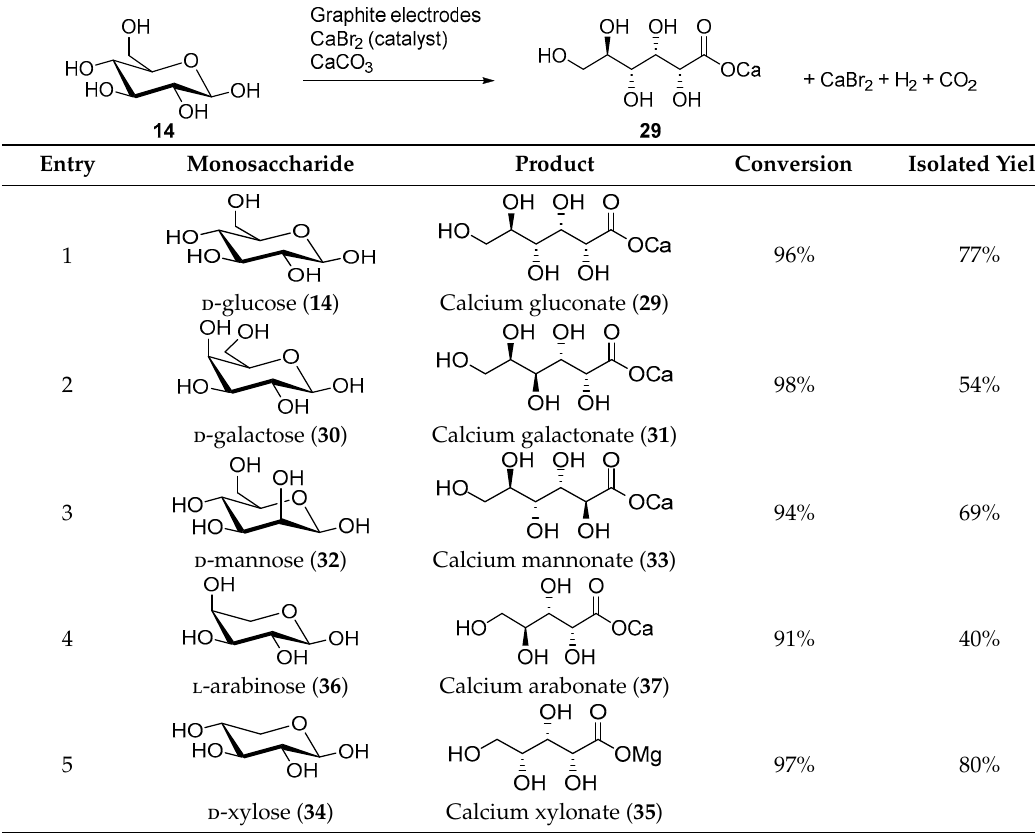
Table 3. Bromide-mediated indirect electro-oxidation of monosaccharides.